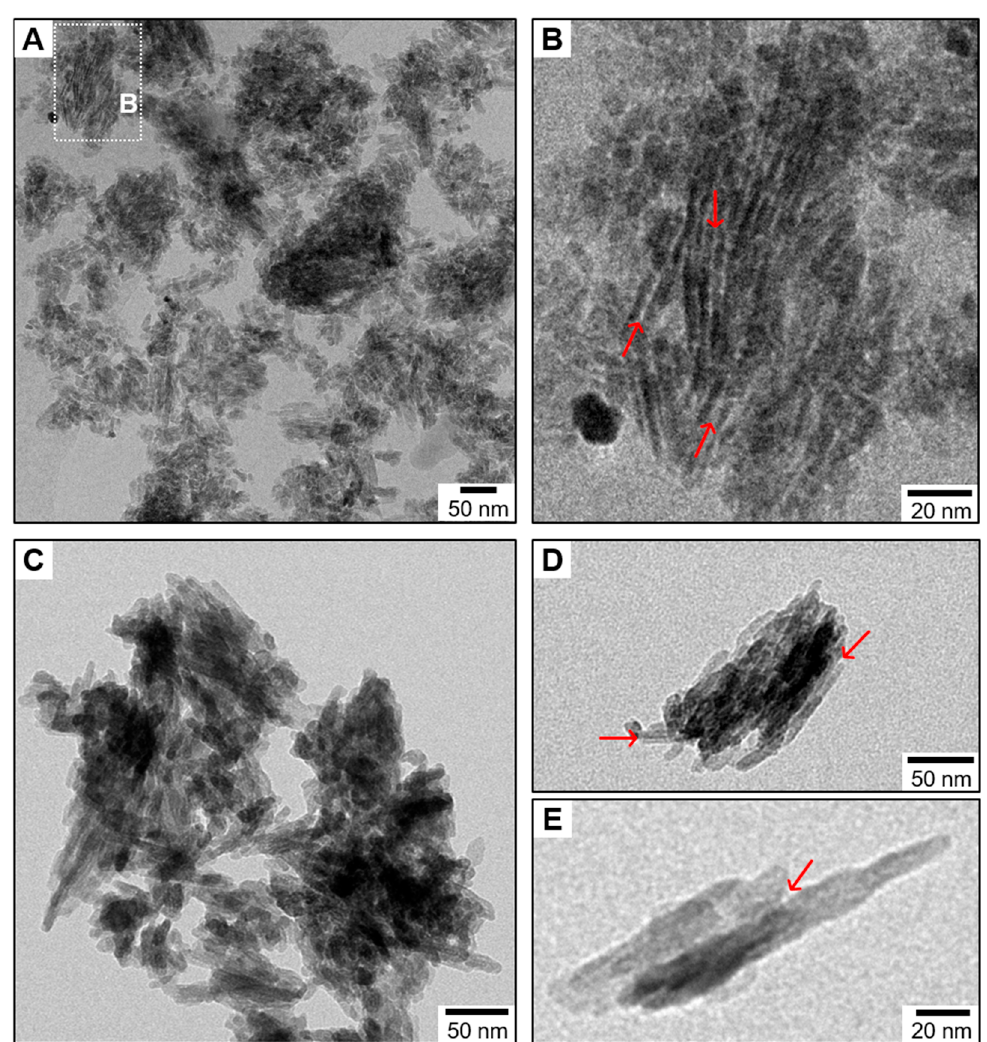
Figure 6. Behavior of the needle/rod-shaped carbonated hydroxyapatite particles in water and under vacuum. ( A , B ) Representative cryogenic transmission electron micrographs (cryo-TEM) of the synthetic needle/rod-shaped Carbonated HydroxyApatite (CHA-needle/rod) particles dispersed in water. ( B ) shows a magnification of the rectangle region marked by the white dashed-line drawn in ( A ). The red arrows indicate the presence of narrow contrasted gaps in between CHA-needle/rod particles. Representative transmission electron micrographs (TEM) at low magnification ( C ) and at higher magnification ( D , E ) of the copper grid previously examined in cryogenic conditions in ( A , B ). The red arrows now indicate the absence of narrow contrasted gaps in between CHA-needle/rod particles.